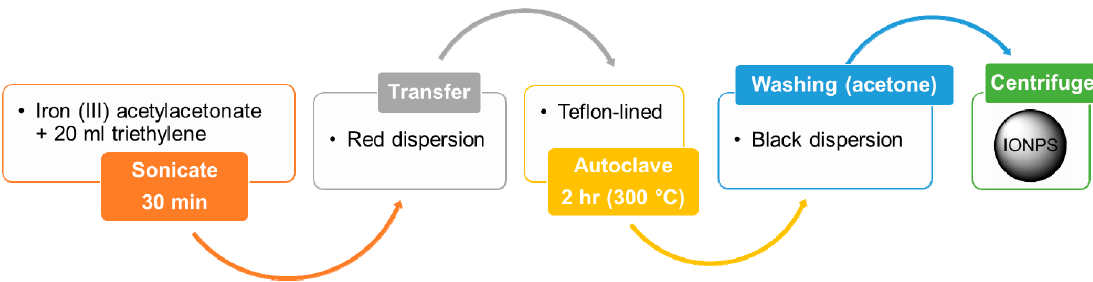
Figure 4. Flowchart for the synthesis of IONPs by polyol method [38]. IONPs are here prepared from a reaction between a metal acetylacetonate (precursor compound) and triethylene (diol solvent).